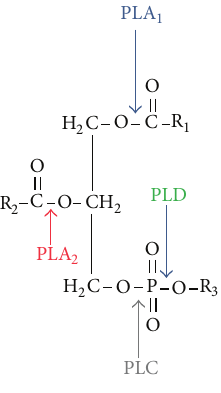
Figure 1: Phospholipases and their role in lipids